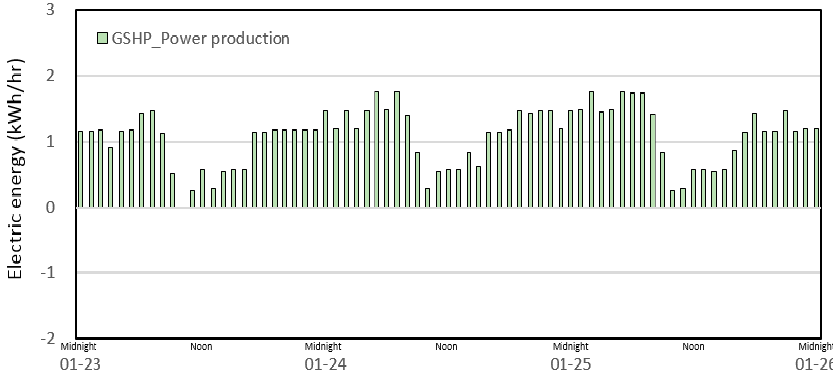
Figure 20. The electric energy of the GSHP system in representing day.